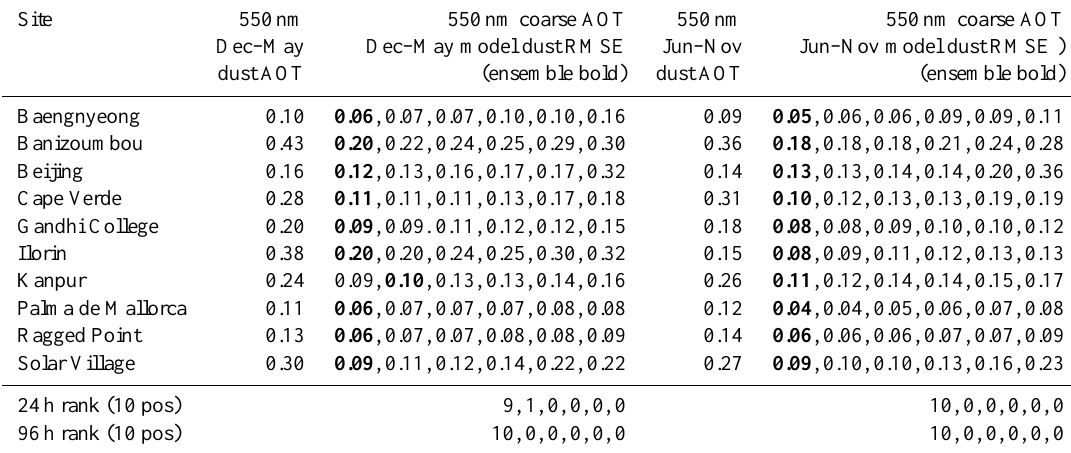
Table 4. Same as Table 3 but for AERONET coarse mode AOT and model dust RMSE, and for those sites in which the coarse mode is dominated by dust. This includes the ICAP core and NGAC